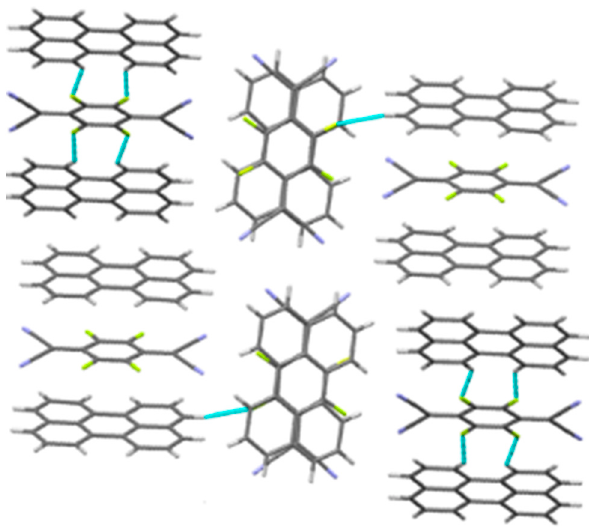
Figure 5. Structure of (Perylene) 3 (TCNQF 4 ) 2 viewed along the a-axis . F ... H contacts are evidenced in turquoise.